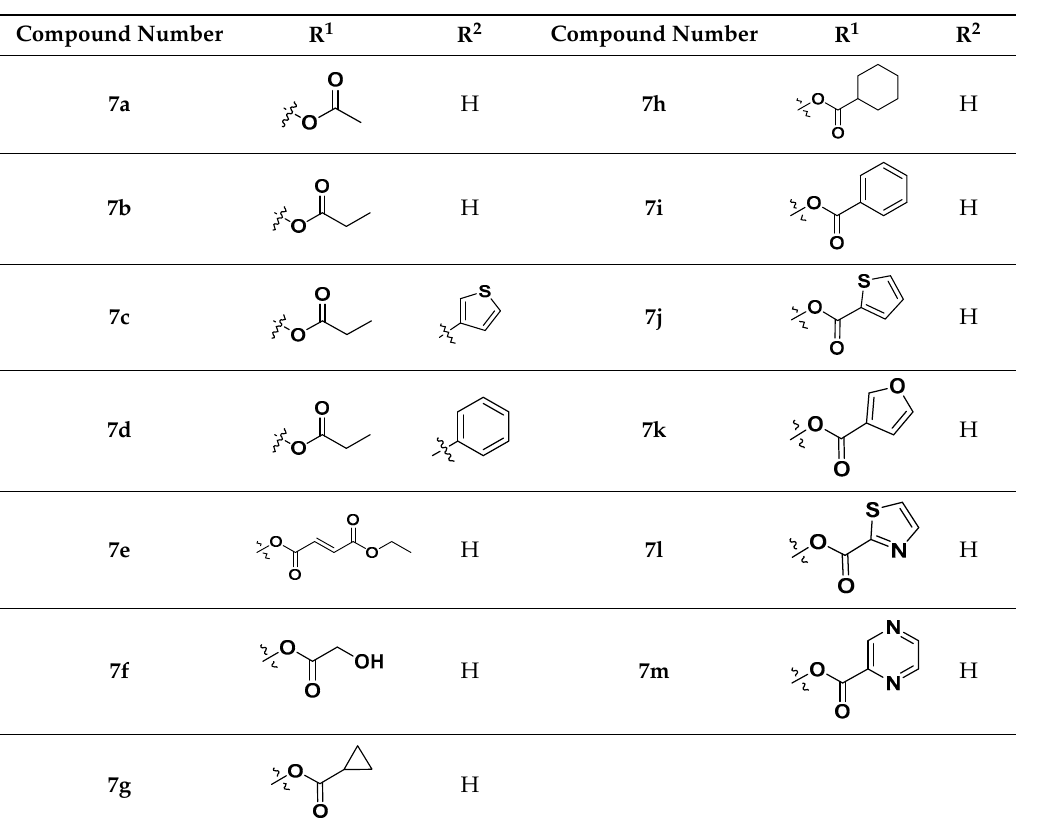
Table 1. Structures of acyloxy derivatives 7a – m.